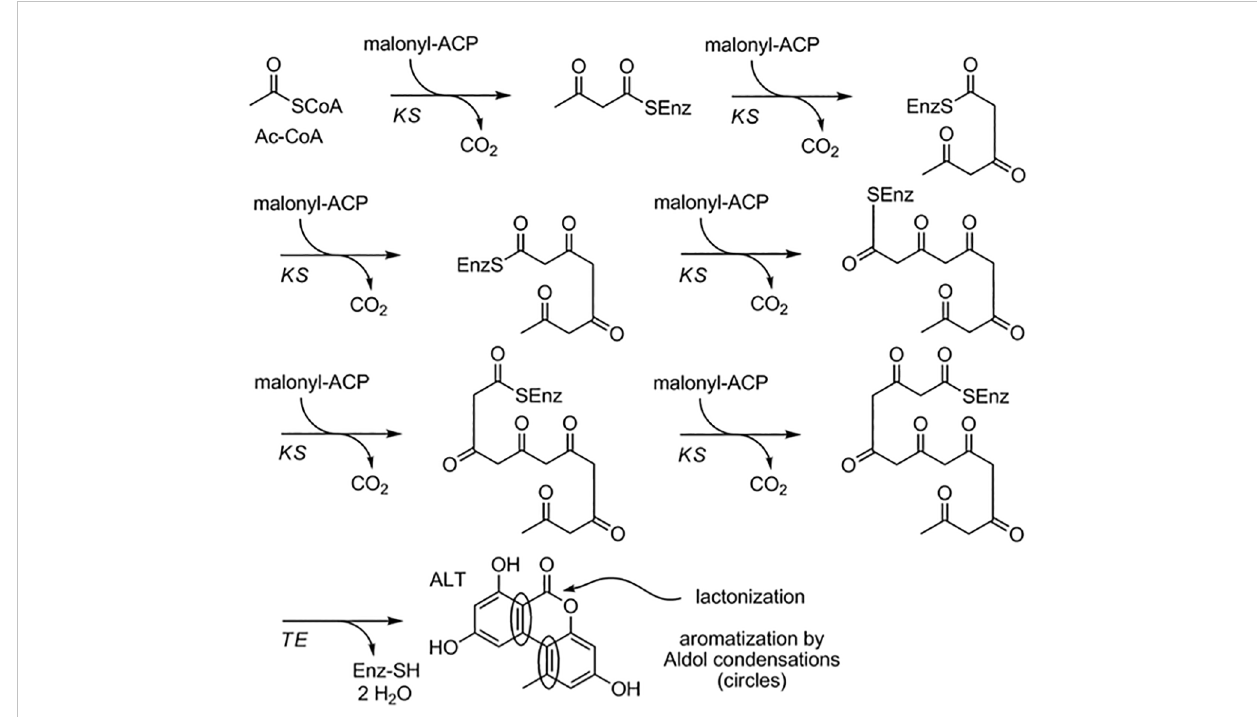
FIGURE 2 Proposed biosynthetic pathway for alternariol and alternariol-9-methyl ether.(Saha et al.,